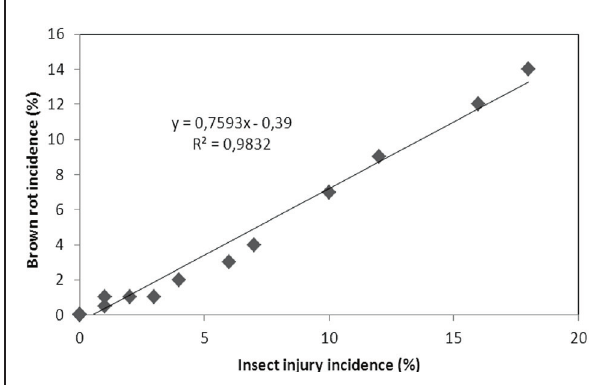
Figure 3. Relationships between overall brown rot incidence and overall insect injury incidence (Eperjeske, Hungary, 2014 and 2015)